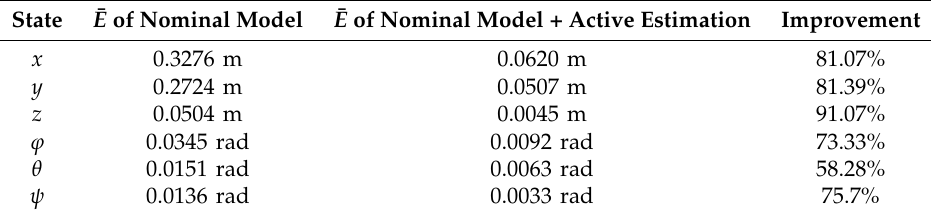
Figure 4. The performance of the active model error estimation (The measurements (black dashed), the nominal model outputs (red dashdot), the desired values (blue solid), or estimated model errors (red dashdot), and the nominal model + modeling errors (green solid) before and after the load change). ( a ) Nominal model output; ( b ) Nominal model output + Modeling error. Table 1. The ¯ E of